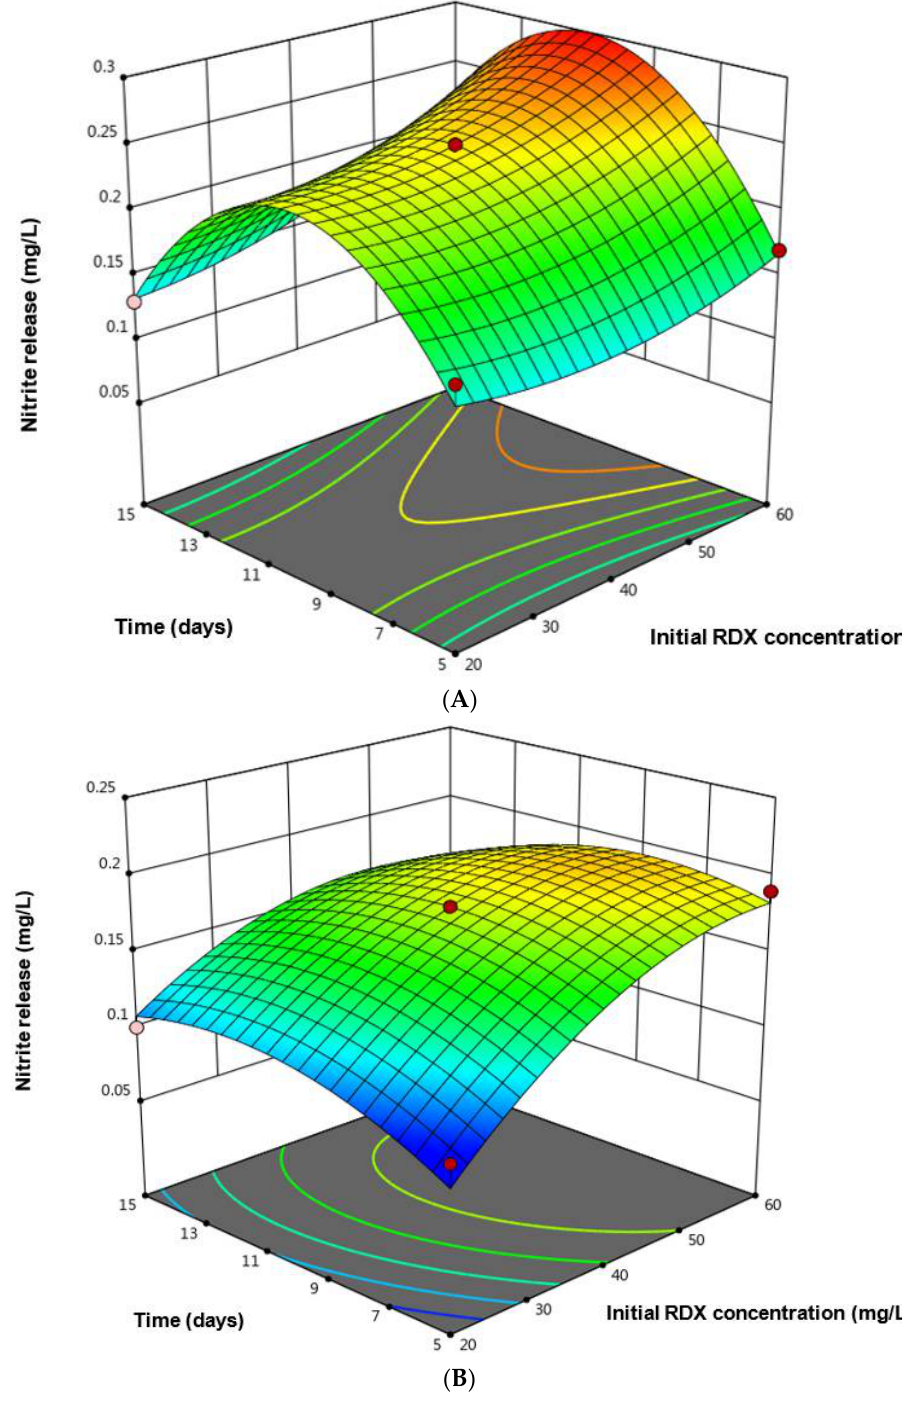
Figure 5. ( A ) Response surface plot (3-D plot) showing interactive effect of RDX concentration (mg/L) and time (days) on nitrite release with Bacillus toyonensis. ( B ) Response surface plot (3-D plot) showing interactive effect of RDX concentration (mg/L) and time (days) on nitrite release with Paenibacillus dendritiformis . Table 4. ANOVA of Quadratic model for the release of nitrite during RDX degradation.